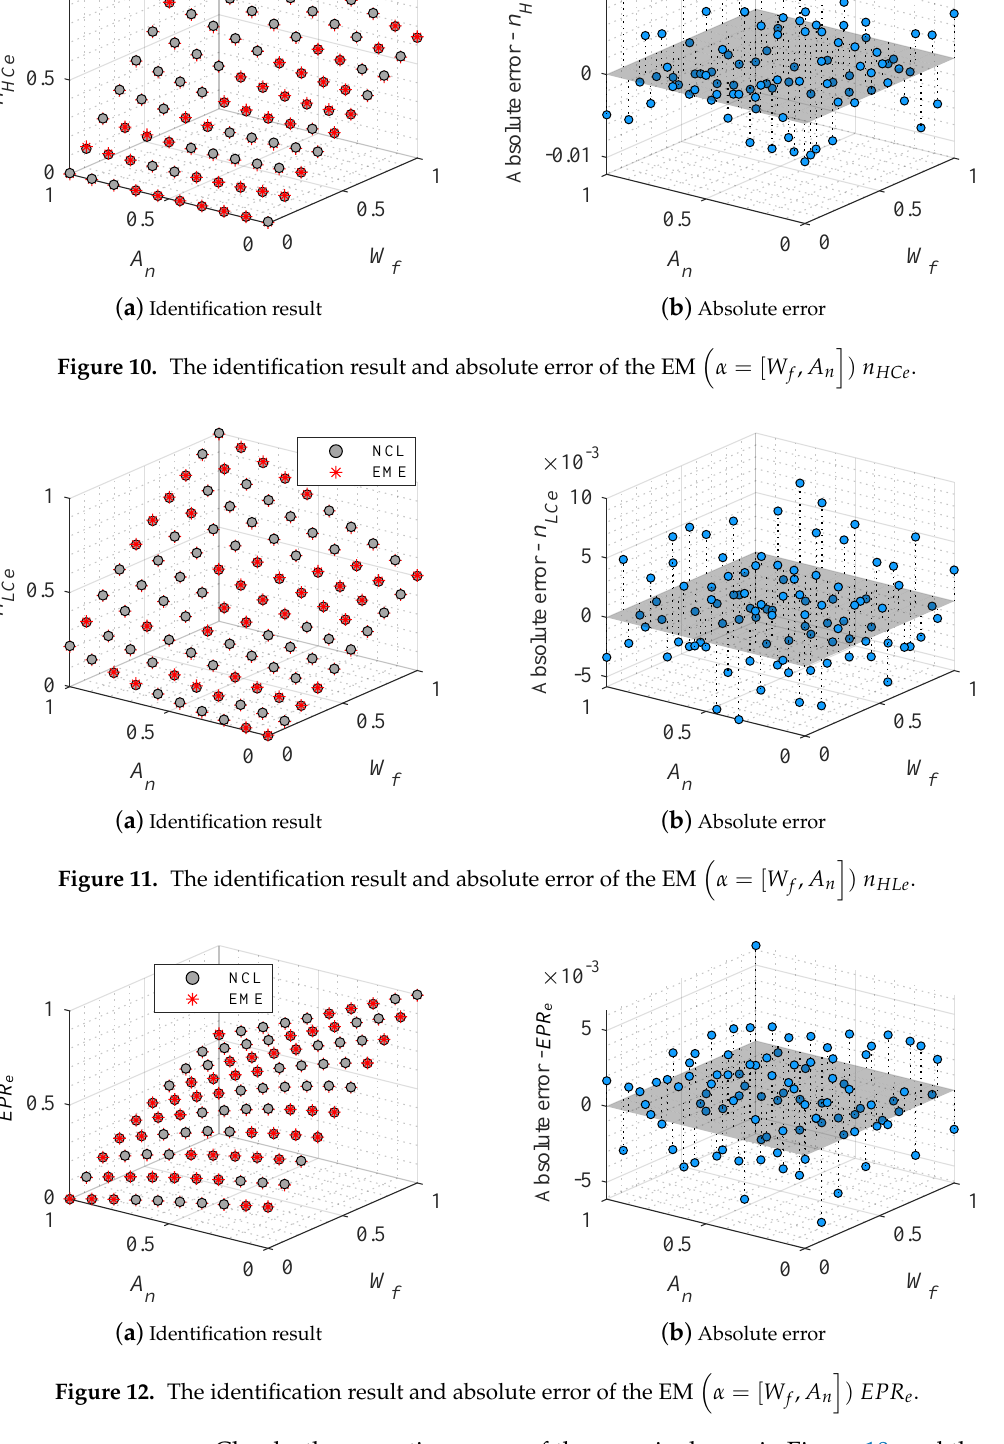
(cid:16) (cid:105) ) EPR e . Figure 12. The identification result and absolute error of the EM α = [ W f , A n Clearly, the operating range of the n HCe is shown in Figure 10, and the maximum ab- (cid:16) (cid:17) W f = 1, A n = 1 solute error is − 0.0120 . However, the strong nonlinear region of the EM (cid:104) (cid:105) W f , A n in EME ( α = [ n HC , A n ] ) is not significant in EME ( α = ). Figure 11 shows that the absolute error range of n LCe is about − 0.006–0.010. The extremum of the absolute errors